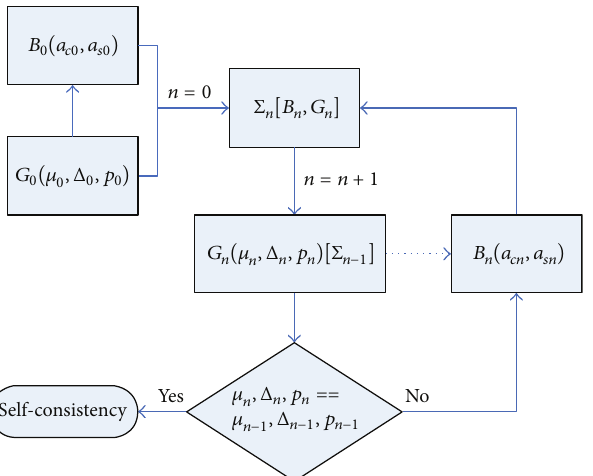
Figure 1: (Color online) Self-consistency scheme to compute the propagator 𝐺 in terms of the charge-charge and spin-spin propagator 𝐵 and the residual self-energy Σ .